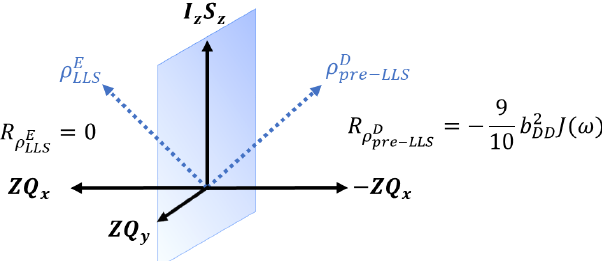
Figure 2. Position of coherence prior to and after zero-quantum rotation with an auto-relaxation rate constant corresponding to the density operator given by the two linear combinations of ZQ x and I z S z . Only the dipolar relaxation mechanism was considered for a pair of two spins where b DD is the dipolar coupling constant and J ( ω ) is the spectral